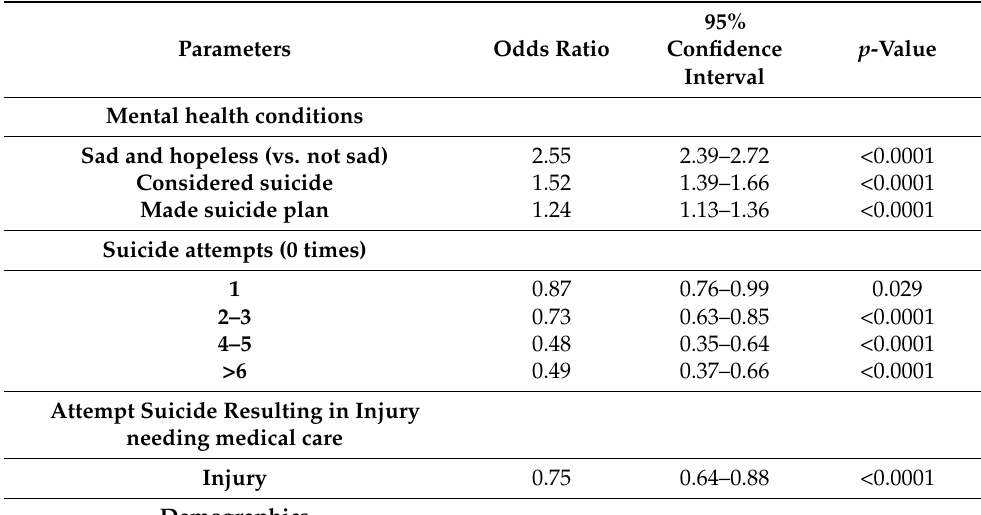
Table 3. Predicted probability of being cyberbullied among adolescents with poor mental health